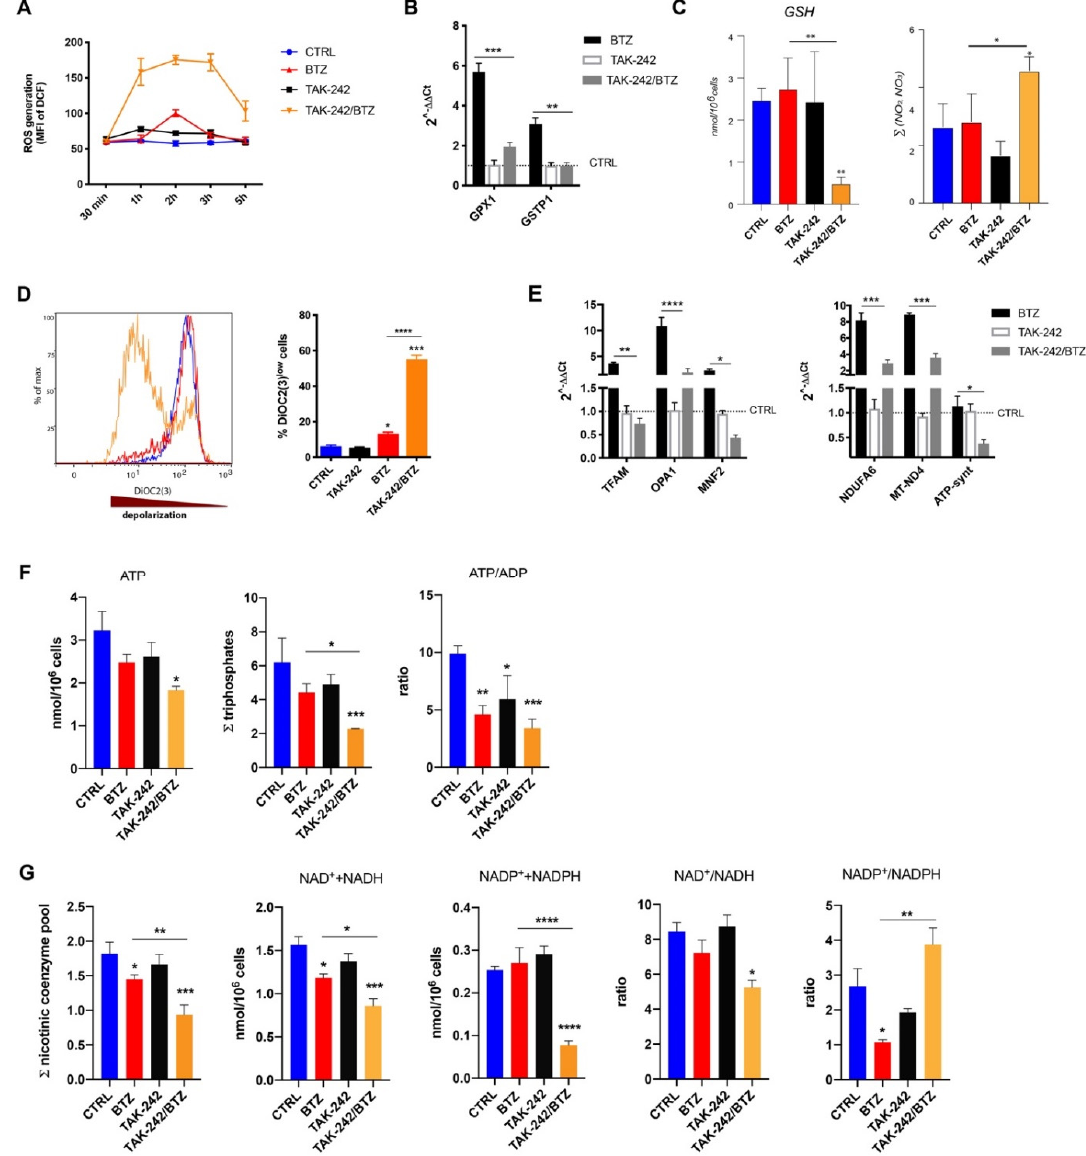
Figure 4. TAK-242/BTZ treatment induced oxidative stress and impaired mitochondria fitness. ( A ) Reactive oxygen species production during drug treatment was measured by oxidation of DCF using flow cytometry. ( B ) The relative gene expression of key cellular antioxidant genes GPX1 and GSTK1 (relative to B2M) was determined by RTqPCR after 4h. Calculated value of 2^- ΔΔ Ct in untreated